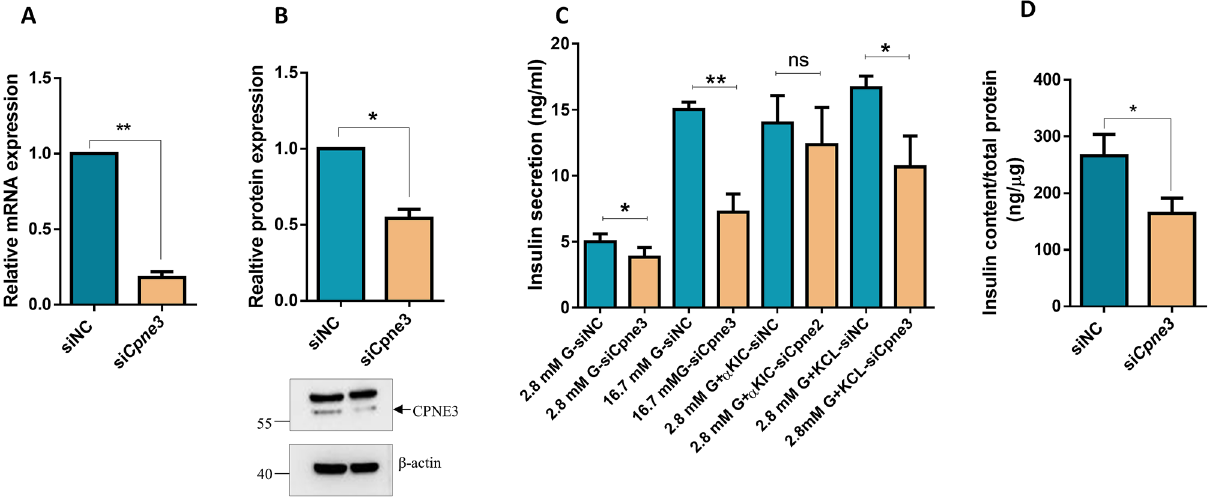
Figure 2. Silencing of Cpne3 impairs insulin secretion in INS-1 (832/13) cells. ( A ) Silencing efficiency of Cpne3 48 h after transfection as measured by q-PCR. ( B ) Western blot expression analysis of CPNE3 in INS-1 cells transfected with siRNA against Cpne3 or siRNA negative control relative to the endogenous control β-actin 48 h post-transfection (upper panel). Fold change in the intensity of the western blot band of CPNE3 protein expression relative to the endogenous control β-actin in Cpne3 -silenced cells or negative siRNA control (lower panel). ( C ) Normalized stimulated insulin secretion in response to 2.8 mM glucose, 16.7 mM glucose, 10 mM α-KIC or 35 mM potassium chloride (KCl) in the presence of 2.8 mM glucose in negative control or Cpne3 - silenced cells for one static hour of incubation. ( D ) Insulin content measurements normalized to protein content in Cpne3 -silenced cells compared to negative control cells. Data are obtained from three independent experiments. *p < 0.05 and **p < 0.01. Bars represent mean ±